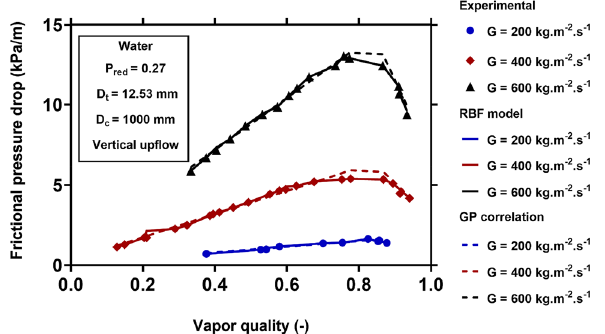
Figure 8. Effect of mass flux on the variation of two-phase FPD versus vapor quality. Comparisons of predictions of GP correlation (Eq. (20)) and RBF model with the corresponding experimental values 51 .